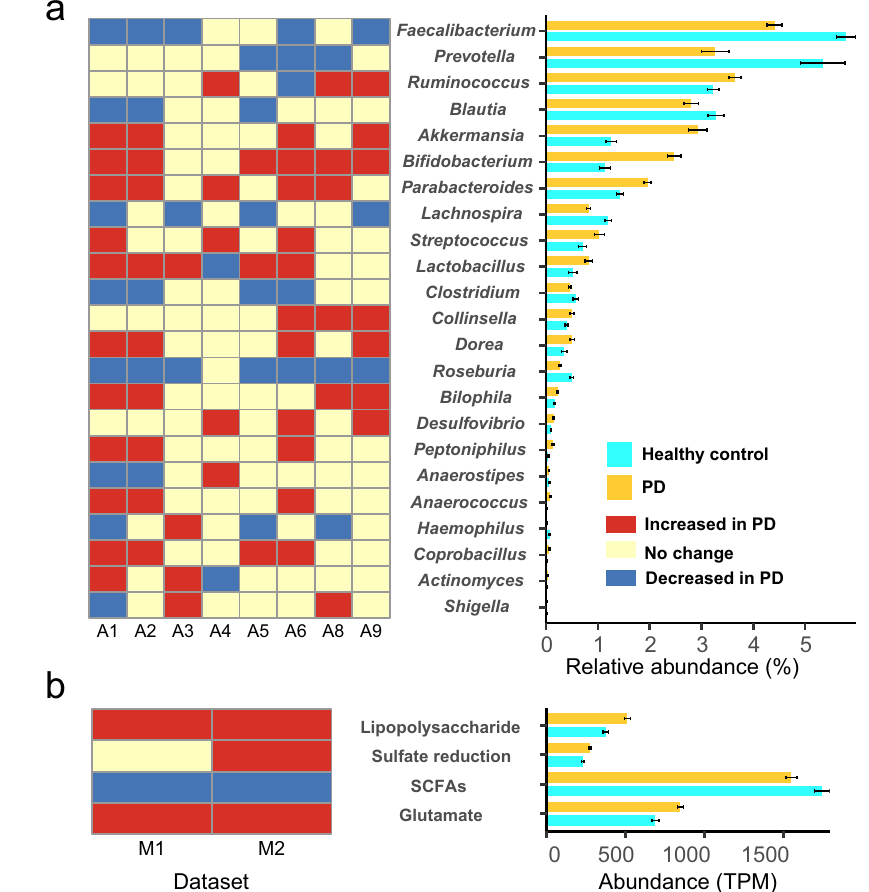
Fig. 3 Differences in microorganisms and metabolic pathways between healthy controls and patients with Parkinson ’ s disease (PD). a Genera with signi fi cant differences in relative abundance. Amplicon datasets (A1 – 9). b Metabolic pathways (related to in fl ammation) with signi fi cant differences in transcripts per million (TPM) abundance. Metagenomic datasets (M1 – 2). SCFAs: short-chain fatty acids. The error bar represents the standard error of the mean abundance in each bar